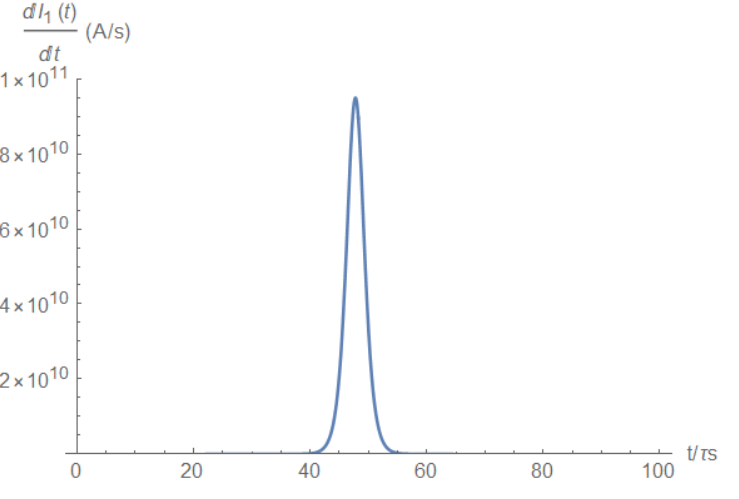
Figure A7. Source current derivative.